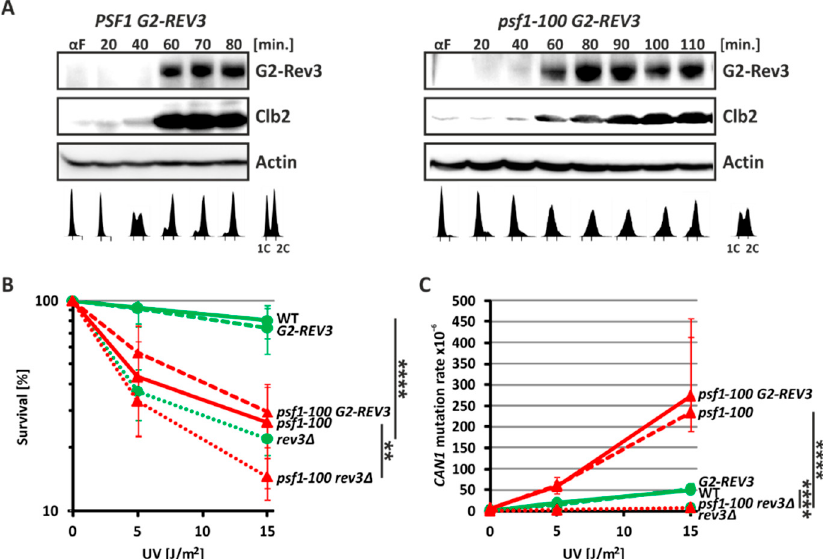
Figure 3. Verification that G2-Rev3 in the constructed strains rescues the phenotypes observed in rev3 ∆ cells. ( A ) Western blot analysis of G2-Rev3 expression. Yeast cells were synchronized with α -factor and released into a new cell cycle. Samples were collected at the indicated times and analyzed using anti-Clb2 and anti-actin antibodies. In parallel propidium iodide staining, FACS analyses of DNA content were performed. ( B ) Sensitivity of wild-type and psf1-100 cells with G2-REV3 to UV light at the indicated doses. The mean survival percentage with SD for exponentially growing cells treated with the indicated doses of UV light is shown. For statistical analyses, a T-test was used to determine the p -value ≤ 0.0001 (****); ≤ 0.01 (**), see Table S4. ( C ) Analysis of UV-induced mutagenesis in wild-type and psf1-100 cells expressing G2-Rev3. Median values of mutation frequencies with 95% confidence intervals were calculated for exponentially growing cells treated with the indicated doses of UV light. For statistical analyses, a Mann-Whitney U test was used to determine the p -value ≤ 0.0001 (****), see also Table S5.